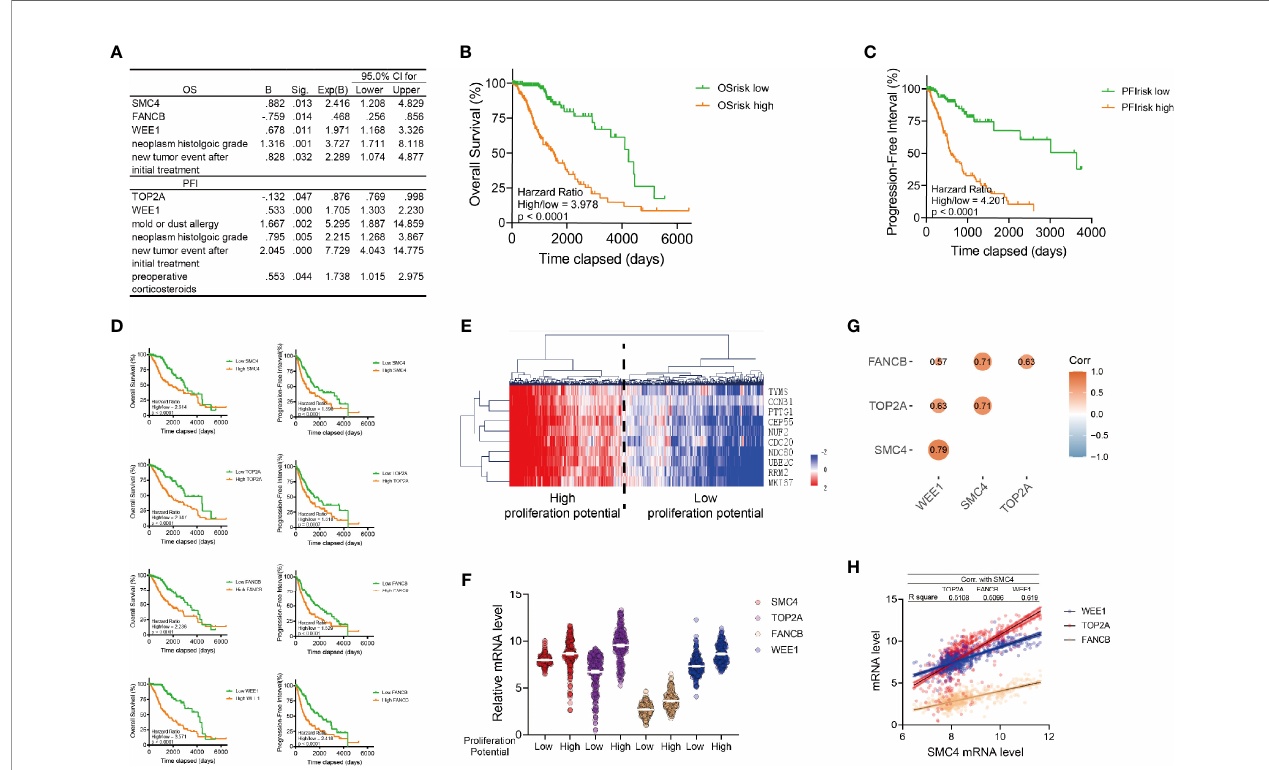
FIGURE 2 | Identi fi cation of SMC4 as a prognostic marker of low-grade glioma patients. (A) Table showing the results of the multivariate Cox Regression for the OS (the top table) or PFI (the bottom table) of LGG patients in TCGA database with Forward Stepwise method in SPSS. Genes or clinical signatures identi fi ed as risk factors are listed in the table. The B factor, p value (Sig.), expected B factor (with 95% CI) are provided for each risk factor. (B, C) Kaplan-Meier analysis comparing the OS (B) and PFI (C) of high or low risk LGG patients. 530 patients were enrolled and divided into high/low-risk groups according to the median of OS risk score or PFI risk score (n high = 265, n low = 265). (D) Kaplan-Meier analysis comparing the OS and PFI in glioma patients according to the expression levels of SMC4, TOP2A, FANCB and WEE1. 530 patients were enrolled and divided into high/low-risk groups according to the median of their respective risk score (n high = 265, n low = 265). (E) Heatmap and Hierarchical Clustering showing the proliferation potency of glioma patients. Patients were divided into high or low proliferative potential group according to the Hierarchical Clustering results. Proliferation markers are TYMS, CCNB1, PTTG1, CEP55, NUF2, CDC20, NDC80, UBE2C, RRM2 and MKI67. (F) Violin plot showing the expression of SMC4, TOP2A, FANCB and WEE1 in high/low proliferative LGG patients (n = 530). High or low expression levels are de fi ned with the median. (G) The correlation between SMC4, TOP2A, FANCB and WEE1 mRNA levels in LGG patients from TCGA database (n = 530). The size and color of each dot represents correlation coef fi cient. (H) Dot plot and linear regression showing the correlation between the SMC4 mRNA and the WEE1, TOP2A or FANCB mRNA (n = 530). The R square of linear regression model is labeled in the table above the fi gure. OS, Overall Survival; PFI, Progression-Free Interval; LGG, lower-grade